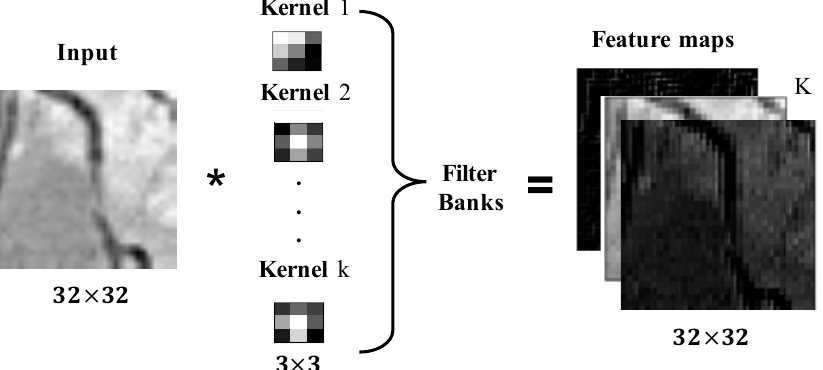
Figure 2. Illustration of a module of convolutional layers and the output feature maps. A 32 × 32 input image is convolved with a set of 3 × 3 kernels to obtain K feature maps. The number of pixels that filters shift out over the input image is called the stride (here, a stride of 1 was